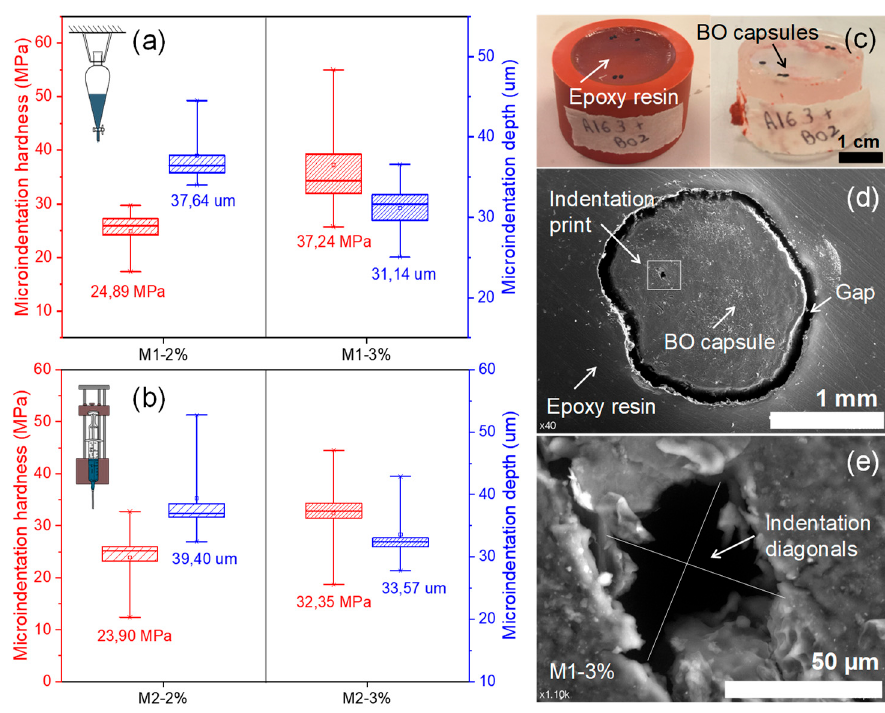
Figure 8. ( a ) Box plots of the results of Vickers micro-indentation hardness and depth for BO capsules produced by method 1; ( b ) box plots of the results of micro-indentation hardness and depth for BO capsules produced by method 2; ( c ) BO capsules embedded in a mould of epoxy resin; ( d ) SEM image of the BO capsule M1–3% taken 24 h after test; ( e ) SEM image detail of the micro-indentation print (i.e., indentation diagonals) in BO capsule M1–3% taken 24 h after test.